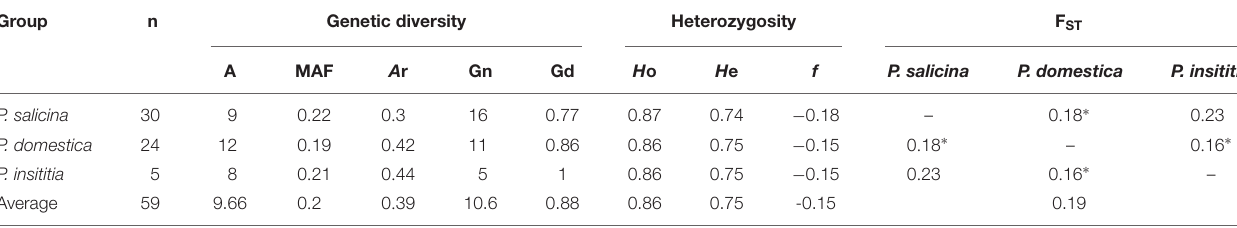
TABLE 6 | Diversity parameters of tested Prunus species based on S -locus markers. Group n Genetic diversity Heterozygosity F ST MAF A r Gn Gd